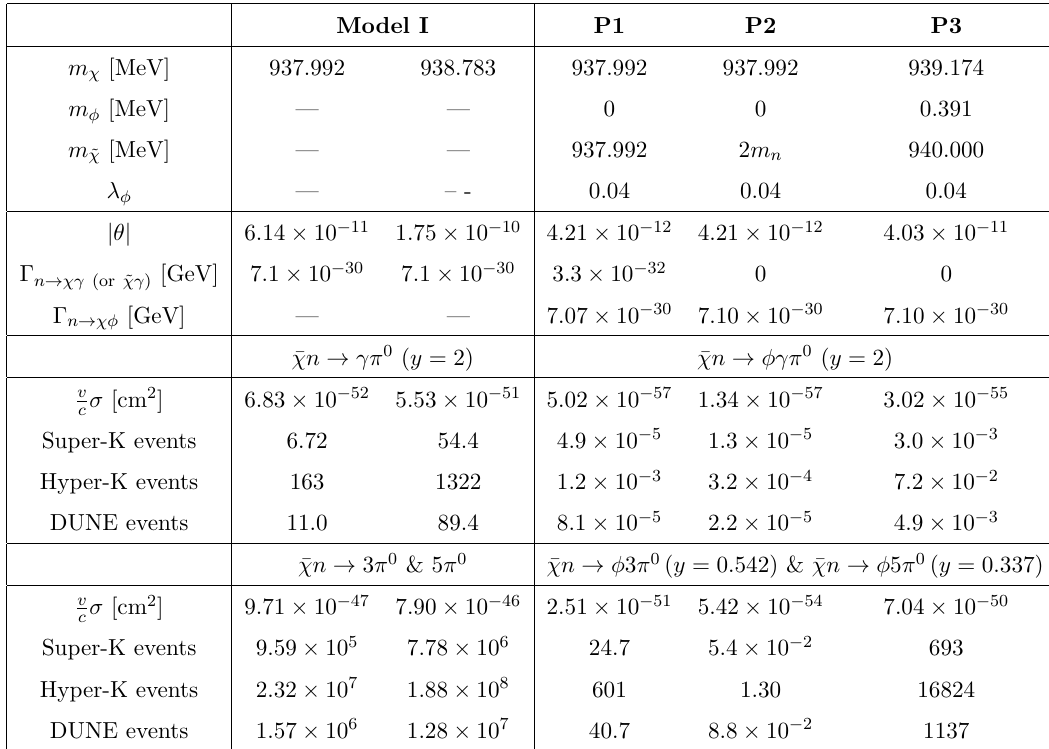
Table 1 . Input parameters and observables for two benchmark points for Model I and points P1 , P2 and P3 for Model II. Experimental cuts have not be